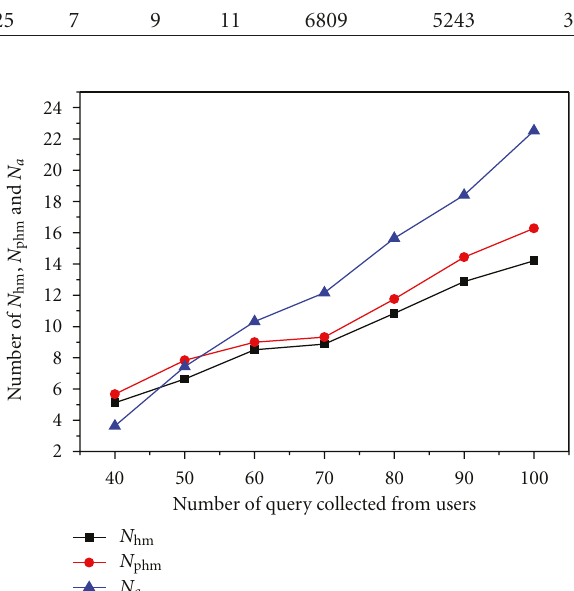
Figure 6: Impact of N h on N hm , N phm and N phm , N a .